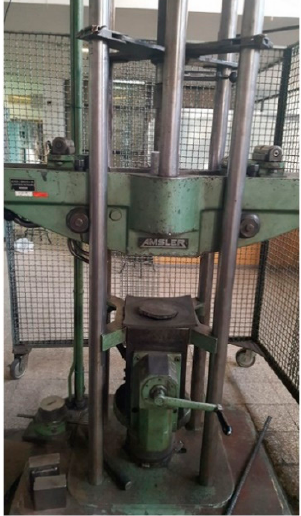
Figure 4. The employed static test facilities.